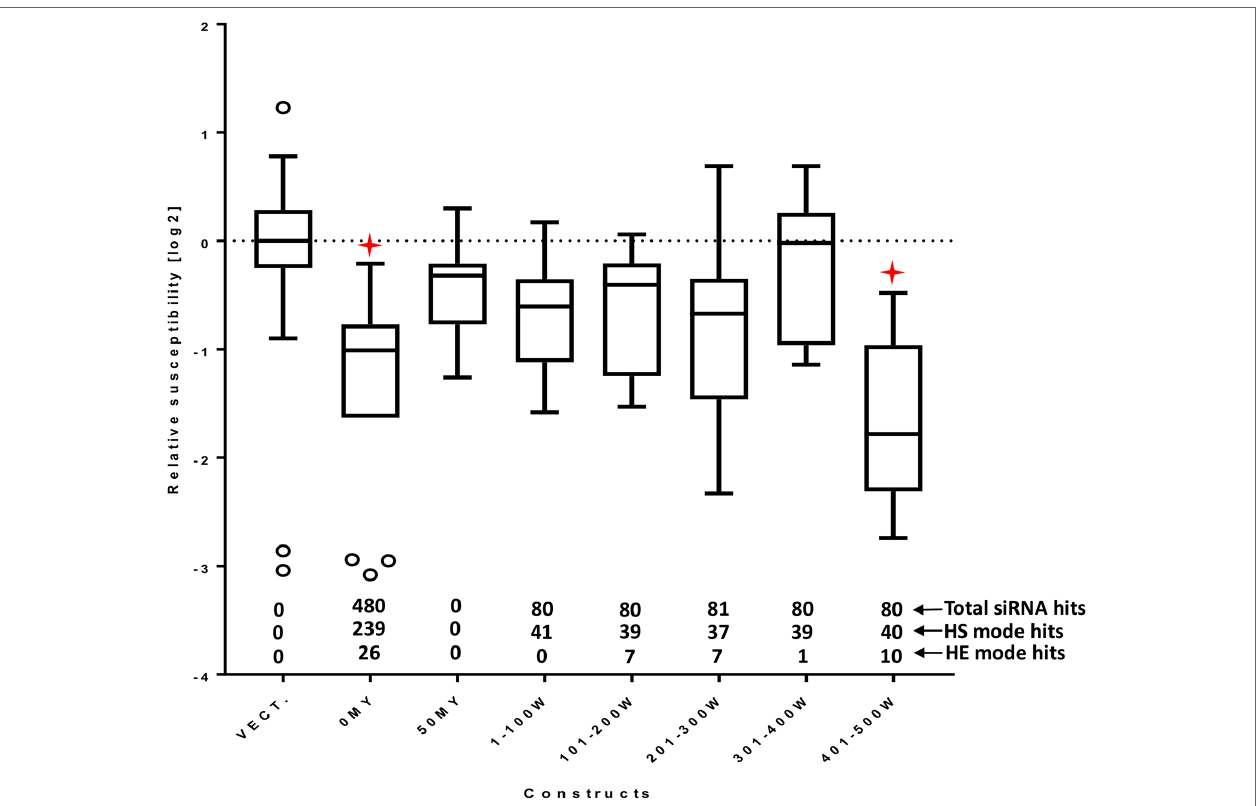
FIGURE 4 | RNAi effect of the 100-bp window constructs as relative susceptibility index (RSI). The number of siRNA hits (total, high-sensitivity selection mode, and high-efficiency selection mode) is indicated above the x-axis. All RSI values are normalized to the empty vector control for the corresponding experiment and log 2 transformed. Lower values indicate stronger effect (decreased susceptibility). The boxes extend from the 25th to the 75th percentiles; the whiskers and outliers are calculated according to Tukey by GraphPad Prism (GraphPad Software, La Jolla CA) v. 7.00. Red stars indicate adjusted p-values (Dunnett’s multiple comparison test) < 0.05 in one-way ANOVA of each construct vs. empty vector